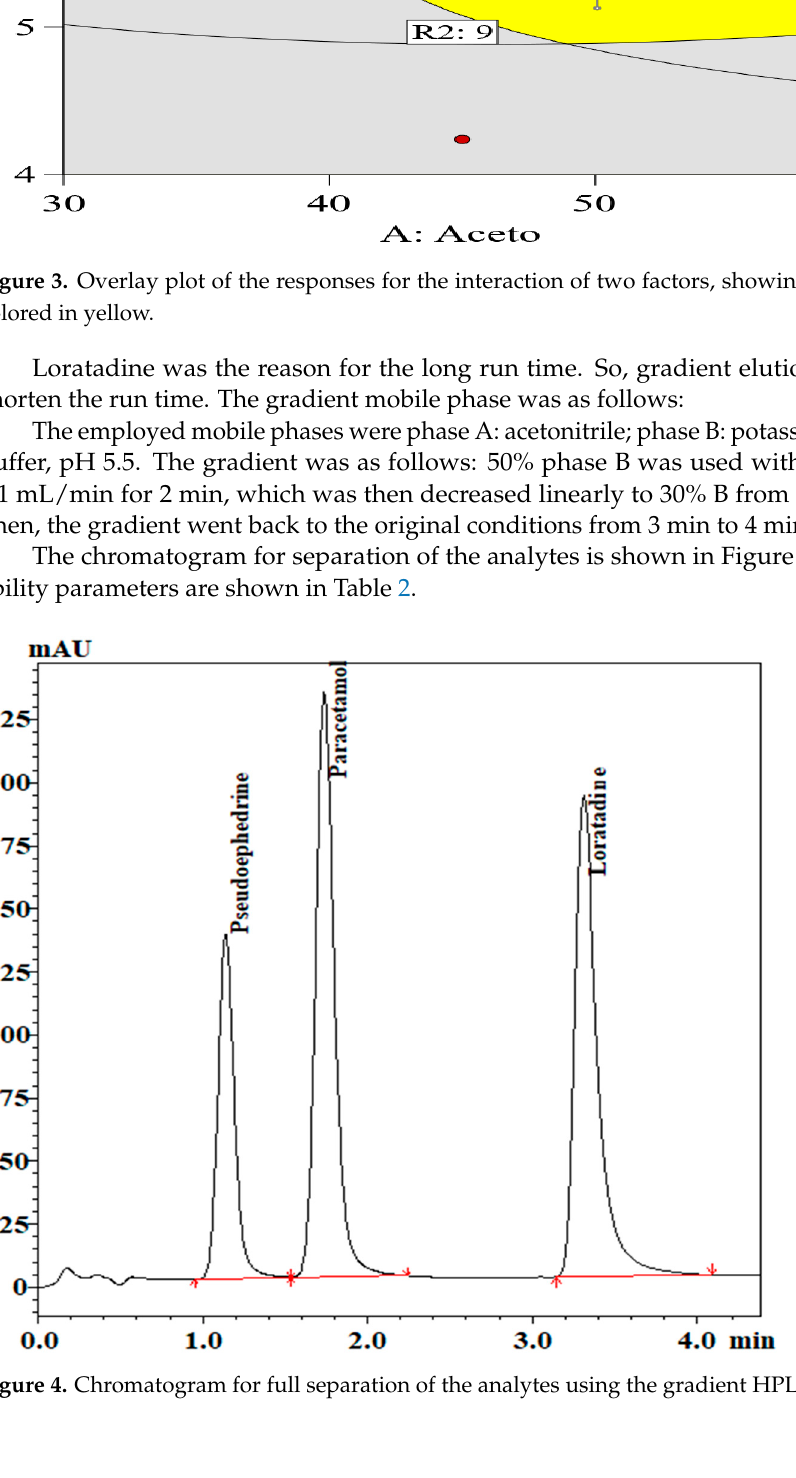
Figure 2 . Selected surface and contour plots for the interaction effect of factors on certain re- sponses .